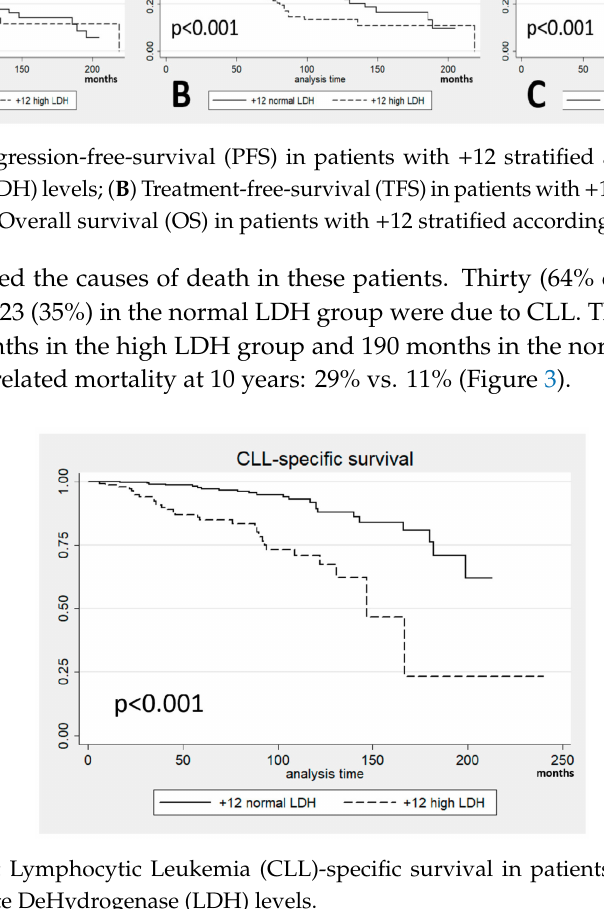
Figure 3. Chronic Lymphocytic Leukemia (CLL)-specific survival in patients with + 12 stratified according to Lactate DeHydrogenase (LDH)